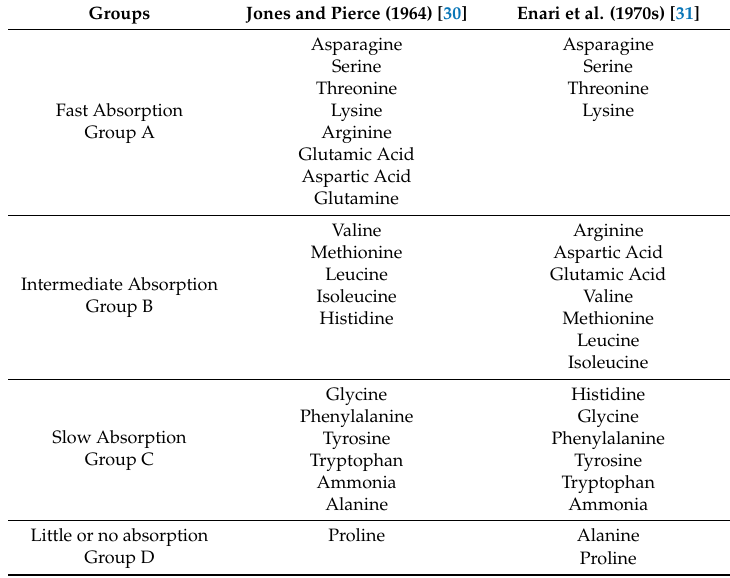
Table 4. Classification of amino acids based on absorption rates from wort.